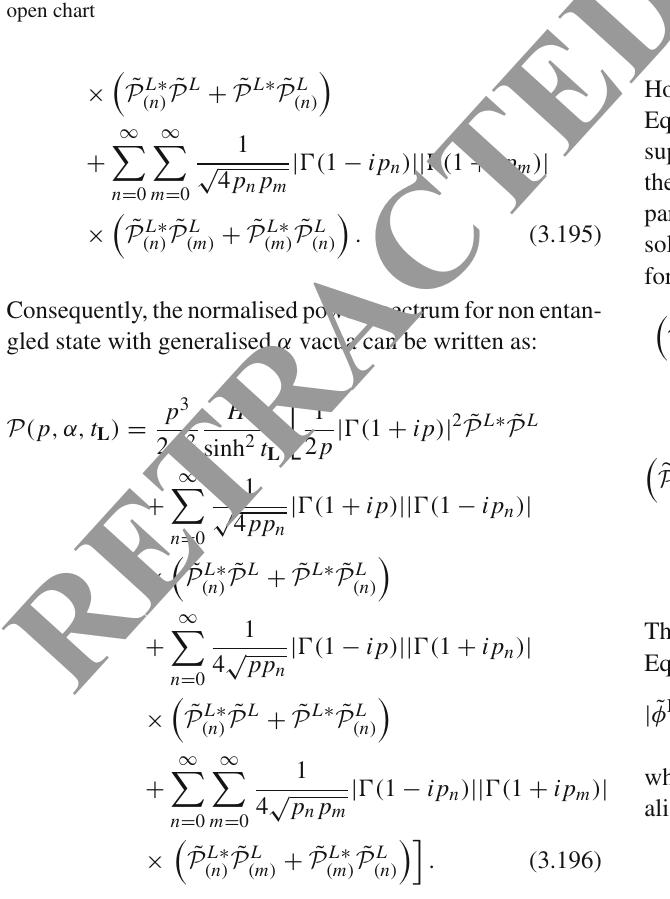
Fig. 11 Schematic diagram for the computation algorithm of NES formalism for non entangled quantum state of axion in de Sitter hyperbolic open chart (cid:7) ˜ P L + ˜ P L ∗ ˜ P L ˜ P L ∗ × ( n ) ( n